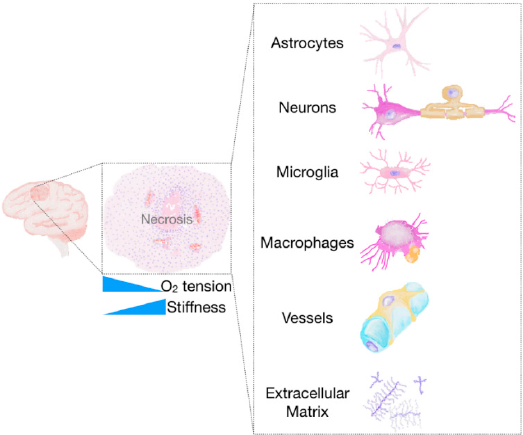
Figure 2. The glioma microenvironment. The glioma microenvironment consists, besides of tumour cells, of different cell types (including endothelial cells, astrocytes and microglia) as well as the extracellular matrix (ECM). The presence of necrotic areas can cause oxygen (O 2 ), pH and nutrient gradients. Additionally, tumour regions are characterized by an increased stiffness with respect to the surrounding brain parenchyma. Rare stem cells (NSC, GASC and MSC) and interstitial flow, although not depicted here, paly also a role in the glioma